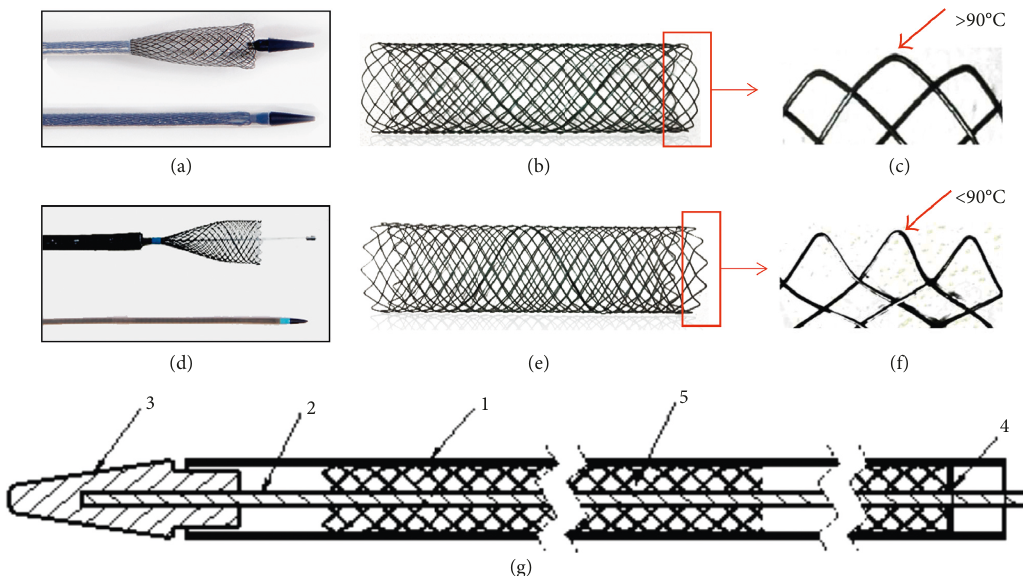
Figure 1: TTS structure, improvement, and trail protocol. (a, b): The general appearance of OTW (over-the-wire) stent. (c) The end structure of OTW stent showed obtuse angle (arrow). (d) TTS (through-the-scope) stent in a bronchoscopy. (e) The general appearance of TTS stent which was weaved using INTI wire (diameter 0.22 μ m). (f) The end structure of TTS stent showed acute angle (arrow). (g) The TTS structure simply diagram (1: outer tube, diameter 2.67mm; 2: inner core; 3: head-end; 4: mark of stent length; 5: TTS stent).